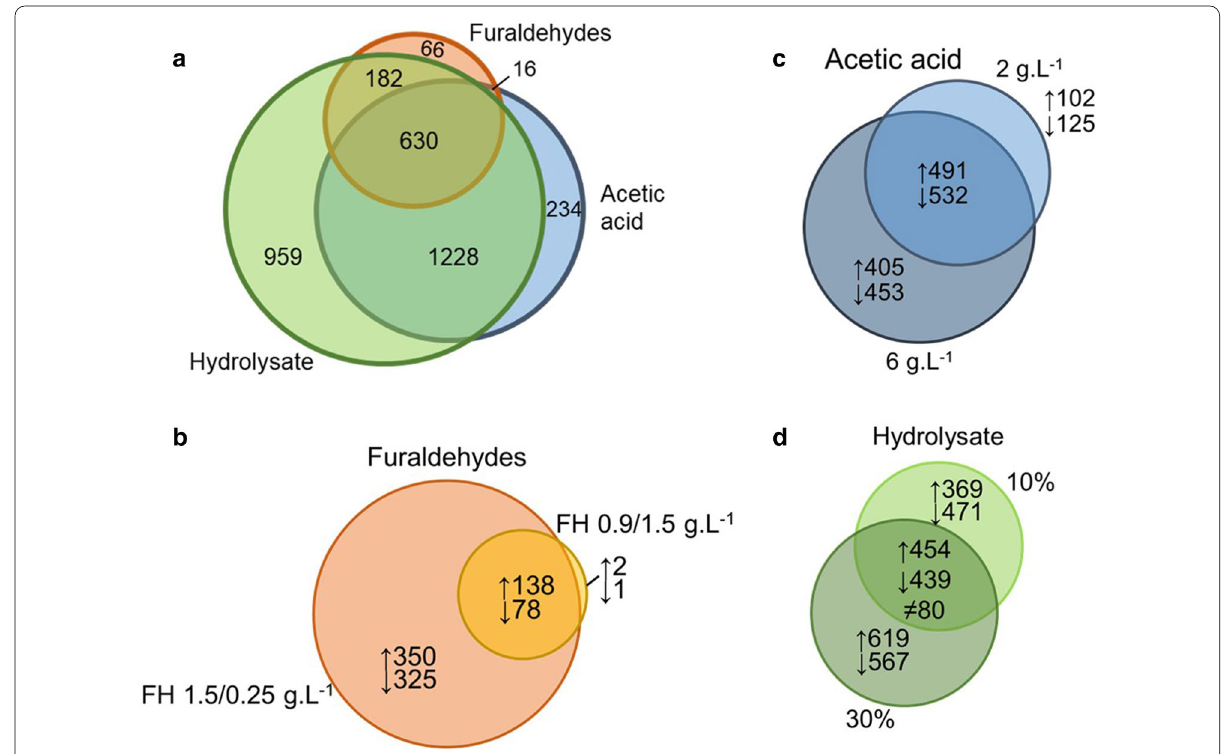
Fig. 3 Venn diagrams representing P. pastoris differentially expressed genes (DEGs) in response to lignocellulose-derived inhibitors. a three inhibitors, no concentration differentiation; b acetic acid 2 g.L − 1 and 6 g.L − 1 ; c furaldehydes FH 0.9/ 0.15 g.L − 1 , and FH 1.5/ 0.25 g.L − 1 ; d lignocellulosic hydrolysate 10% and 30%. Numbers account for DEGs that were differentially expressed in at least one of the two concentrations. The symbol ≠ stands for the 80 genes in which behavior changes depending on the hydrolysate